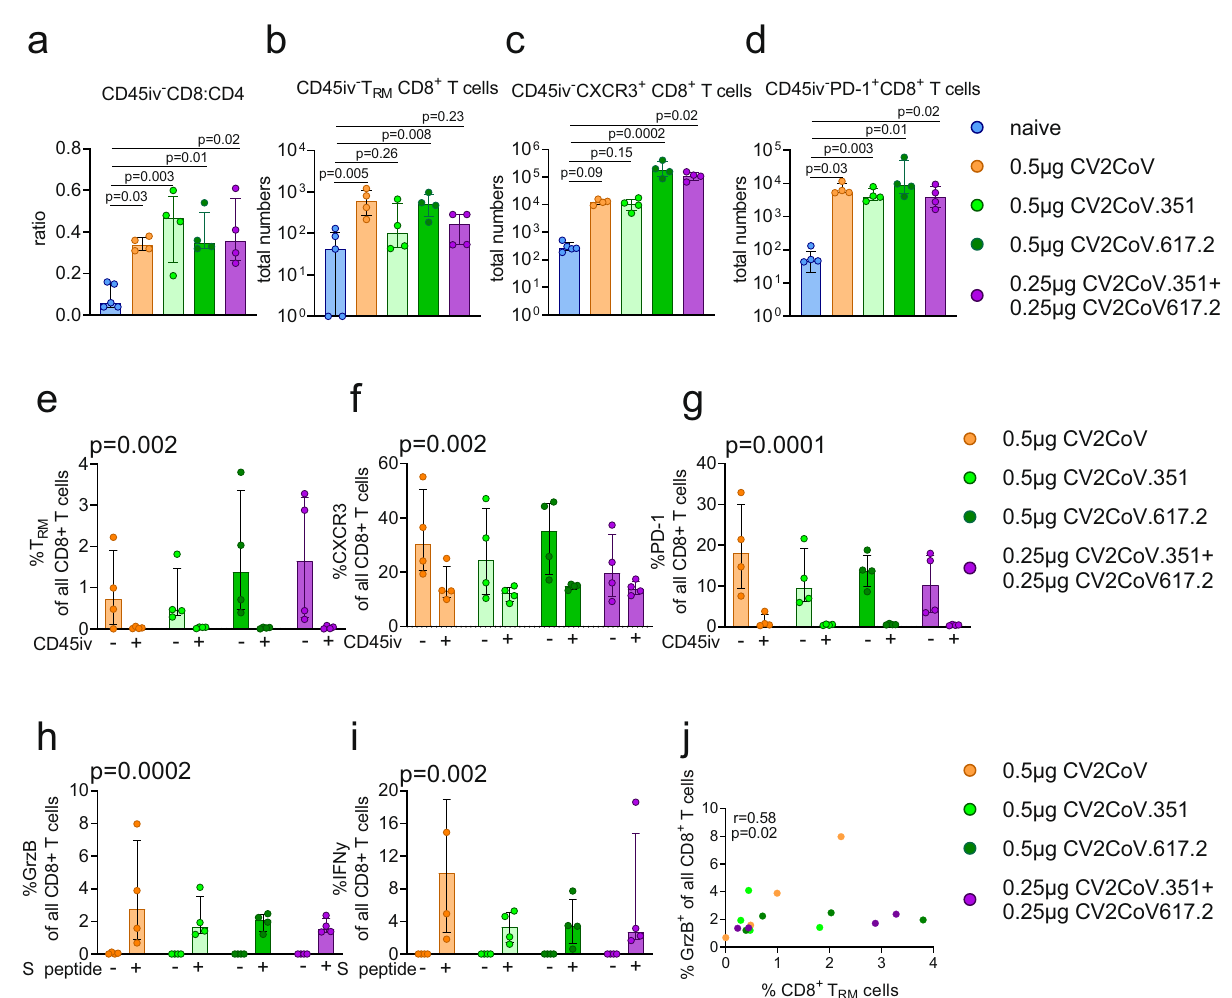
Fig. 3 | SARS-CoV-2 mRNA vaccines induce robust lung CD8 + T cell responses. Lung parenchyma T cells from female K18-hACE2 mice ( N =4 per group) at Day 56 post vaccination were investigated by in vivo injection of anti-mouse CD45 anti- bodies (CD45iv) prior to harvesting of lung tissue. Mice received 0.5 µ g CV2CoV (ancestral, orange), 0.5 µ g CV2CoV.351 (Beta, light green), 0.5 µ g CV2CoV.617.2 (Delta, dark green), CV2CoV.351+CV2CoV.617.2 (0.25 µ g of each; purple) or naive (unvaccinated; blue) a CD8:CD4 ratio of lung CD45iv - T cells. b – d Total number of CD8 + T RM cells (CD45iv - CD3 + γδ TCR - CD8 + CD44 high CD62L - CD103 + CD69 + T cells), CD45iv - CXCR3 + CD8 + T cells and CD45iv - PD-1 + CD8 + T cells after vaccination. e – g Frequency of CD45iv - versus CD45iv + CD8 + T RM cells, CXCR3 + CD8 + T cells and PD-1 + CD8 + T cells after vaccination. h , i Granzyme B (GrzB + ) production by lung